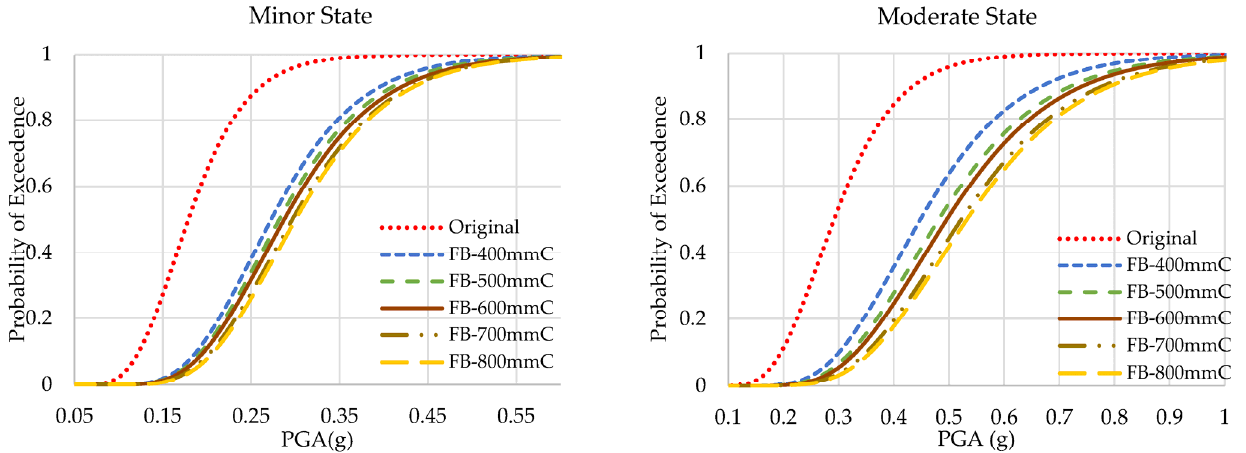
Figure 14. Fragility curves of the original and CFRP flange ‐ bonding frames in each state. Table 8. The PGA (g)’s accordance with the probability of 50% and 100% of each state for FB ‐ GFRP frames. Frame